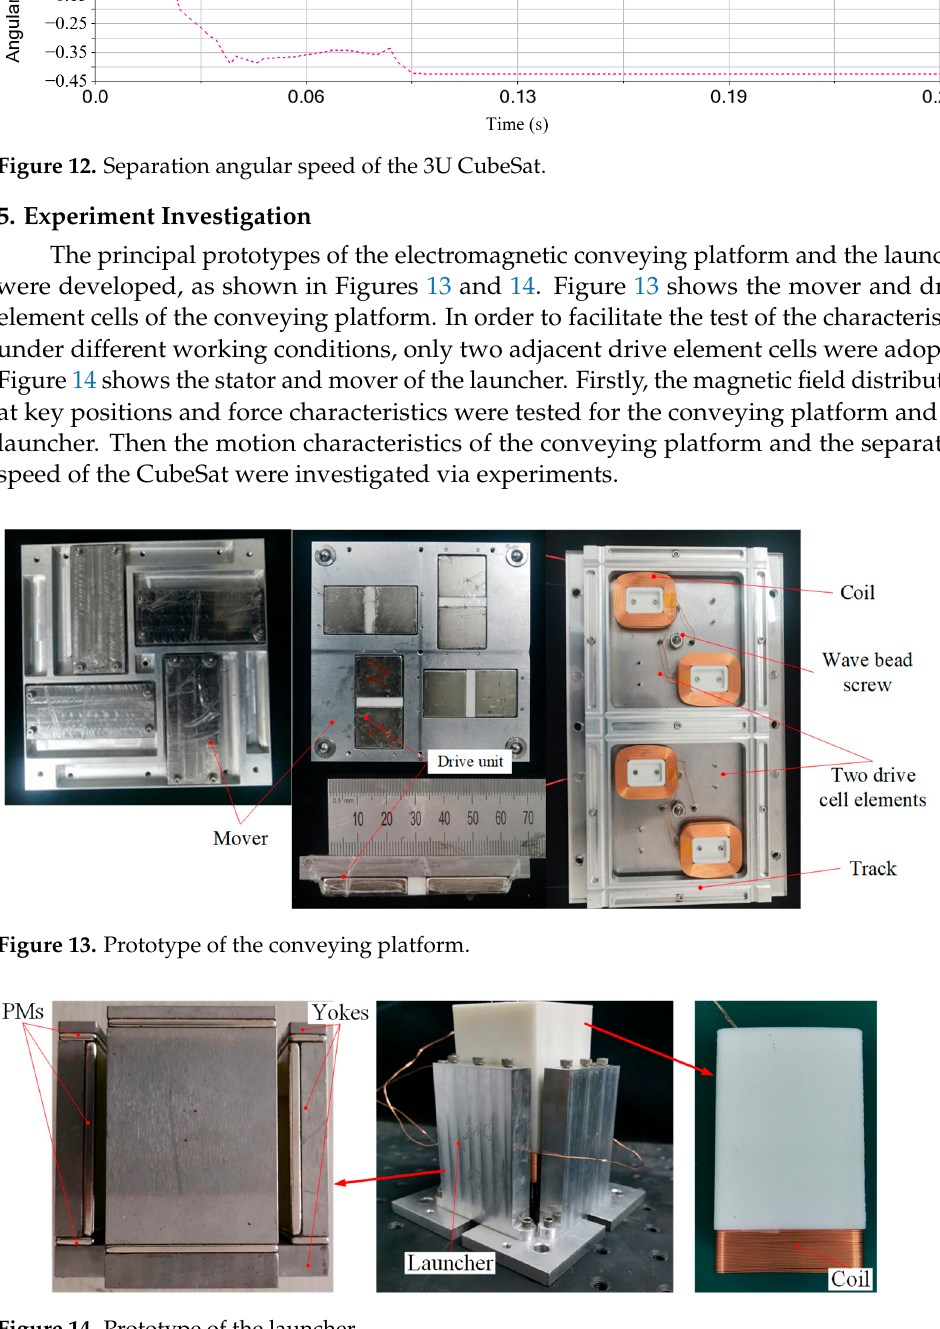
Figure 12. Separation angular speed of the 3U CubeSat.